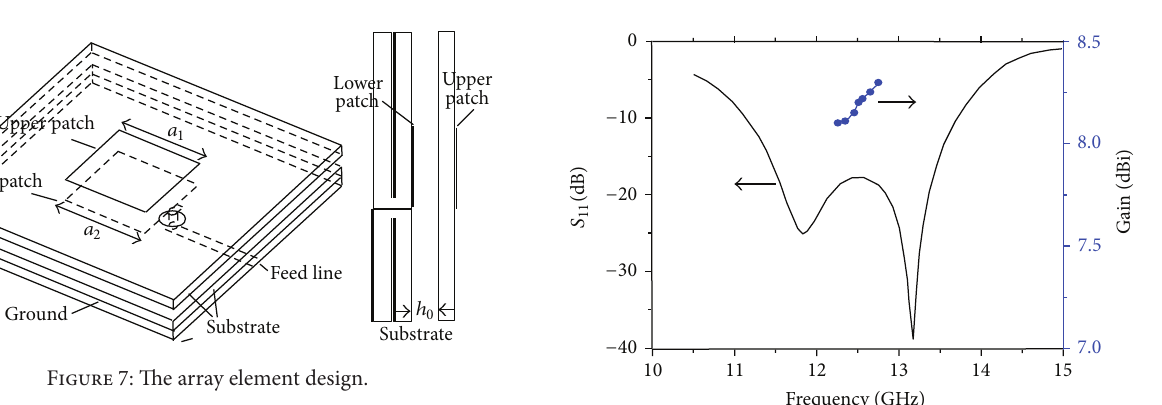
of the element, which consists of three substrate layers. All substrates have the same dielectric constant of 𝜀 𝑟 = 2.55 and thickness ℎ . The upper square patch with a side length of 𝑎 1 is printed on the upper substrate while the lower square patch with a side length of 𝑎 2 is on the middle substrate. The distance between these two substrates is ℎ 0 . The microstrip feed network is printed on the bottom side of the substrate and is isolated from the patches through a metal ground plane, which frees up the design of feed network. The final optimized geometry of the antenna element for the frequency band of 12.25 ∼ 12.75 GHz is listed in Table 2. The